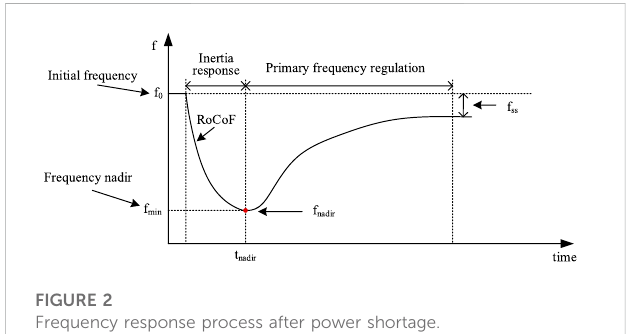
FIGURE 2 Frequency response process after power shortage.